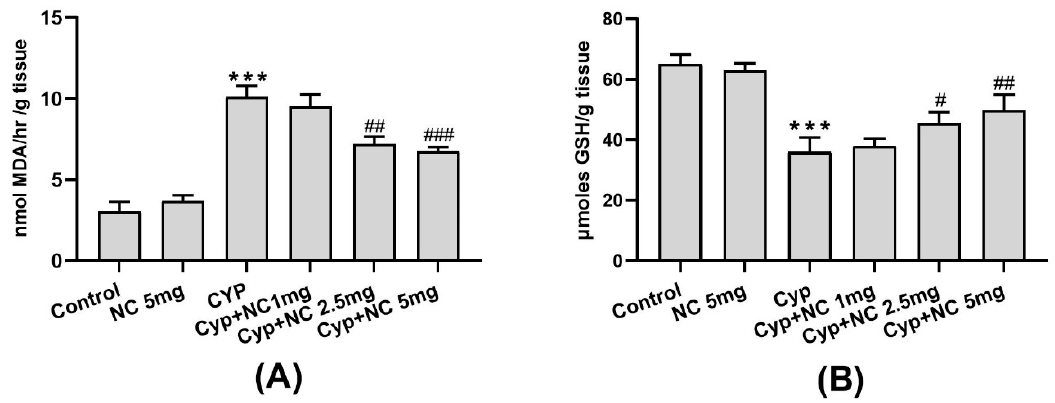
Figure 1. Cur-NLC treatment attenuated the level of LPO ( A ) and GSH ( B ). Values shown as mean ± SEM (n = 6). *** p < 0.001 vs. control, # p < 0.05, ## p < 0.01, ### p < 0.001 vs. Cyp group. Cyp = cypermethrin; NC = NLC.